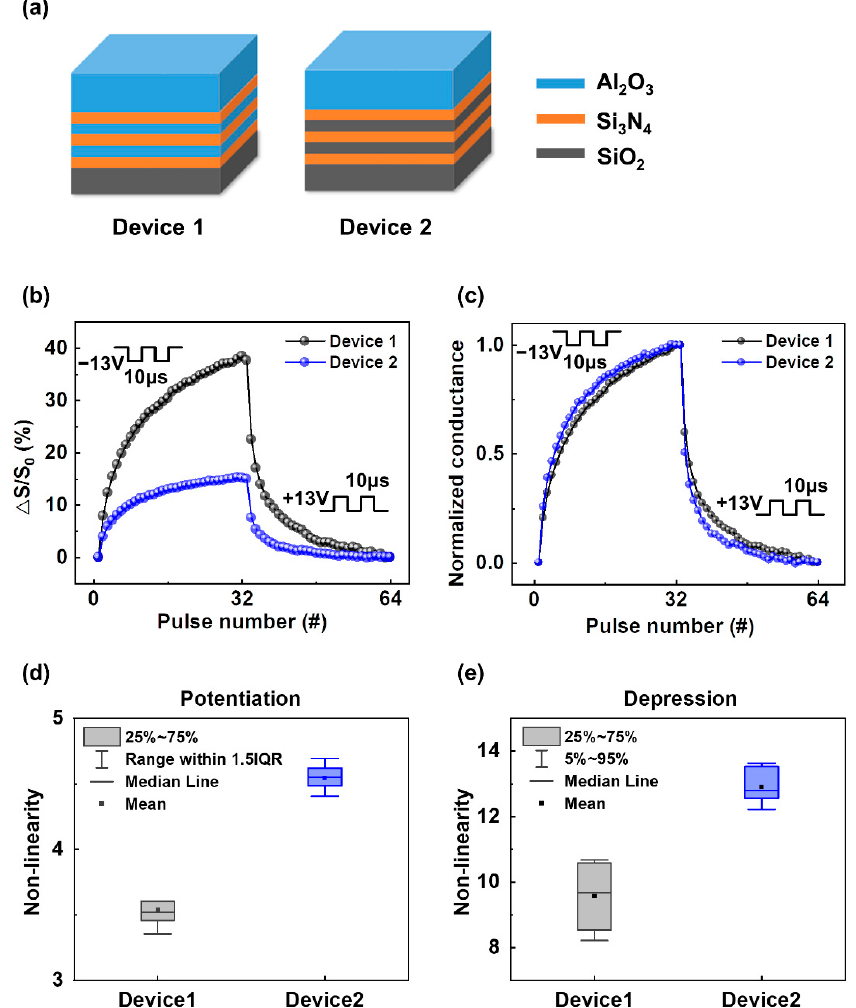
Figure 3. Schematics of multilayered charge trapping stacks and the synaptic properties of the devices. ( a ) Charge trapping layers (Si 3 N 4 ) with different intermediate barrier oxide layers of Al 2 O 3 for Device 1 and SiO 2 for Device 2. ( b , c ) Potentiation and depression curves of Device 1 and 2. The higher coupling ratio (Device 1) shows a higher conductance on/off ratio and a more linear synaptic update. ( d , e ) Nonlinearity values for fourteen cycles of potentiation and depression operations.